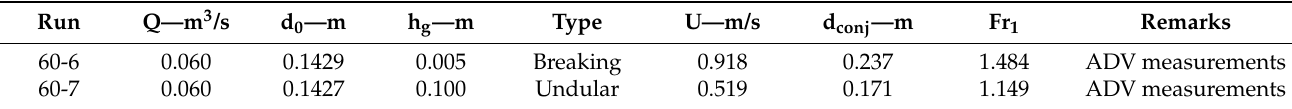
Table 1. Experimental flow